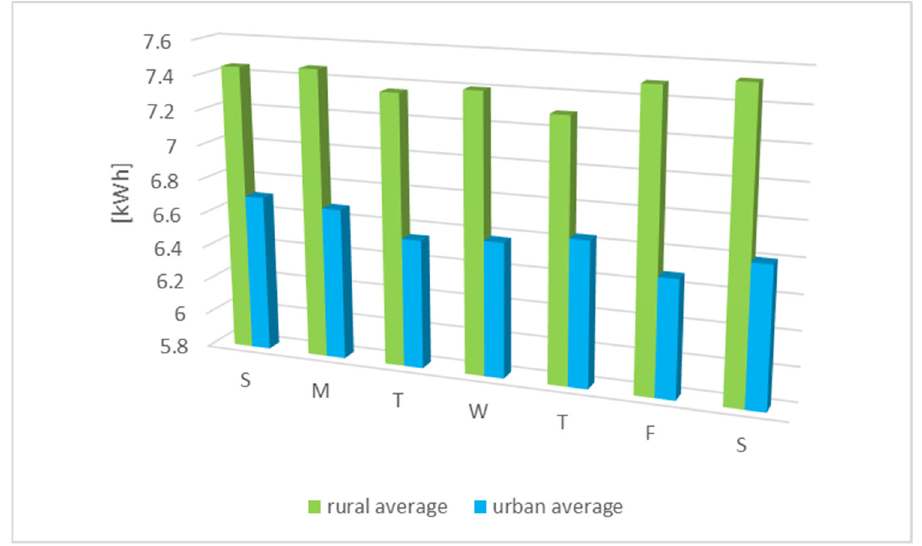
Figure 8. Rural vs. urban weekly consumption patterns.